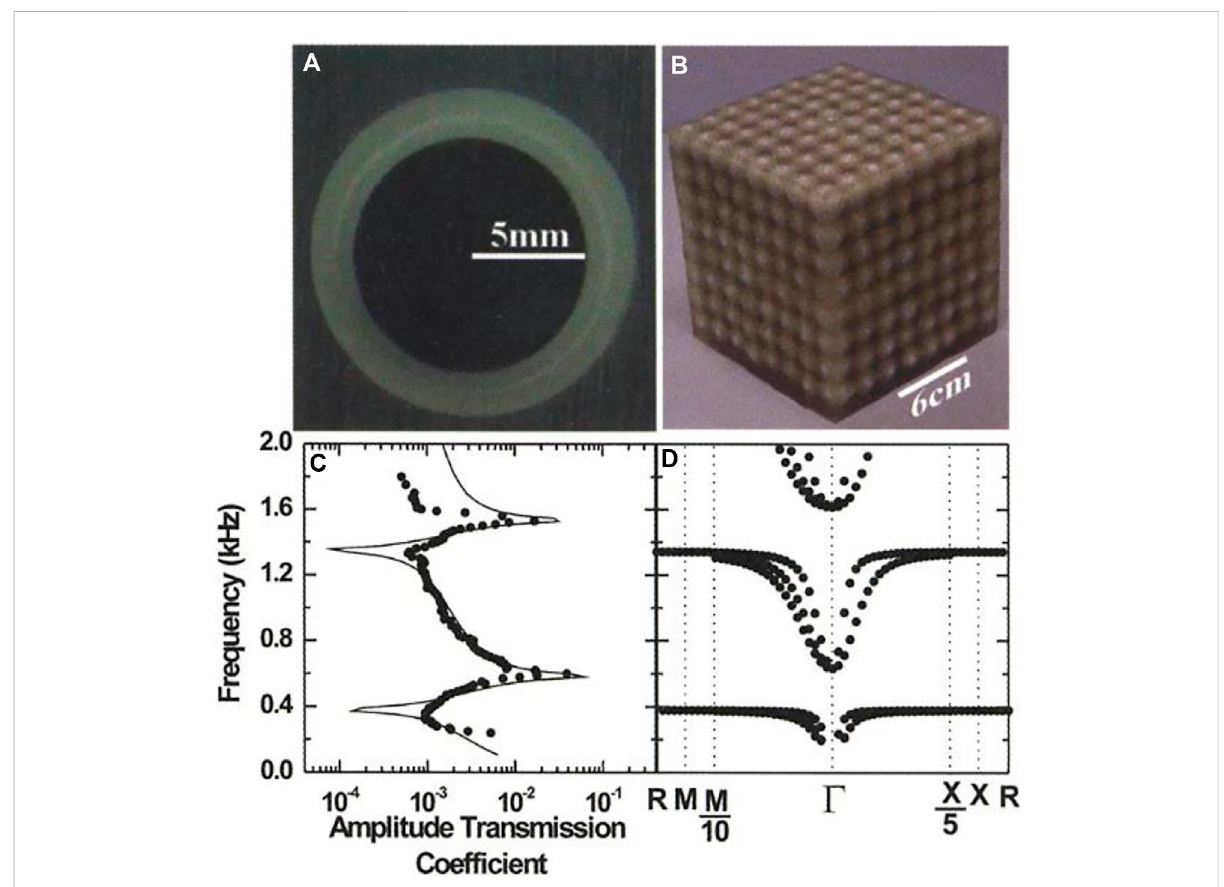
FIGURE 1 (A) The cross-sectionofthecoatedleadball of thebasic structural unit; (B) isan 8 ×8 × 8sonic crystal; (C) Calculated (solid line)and measured (circle) amplitude transfer coef fi cients as a function of frequency; (D) Comparison of the observed transmission properties with the calculated band structure. Reprinted from [14] with